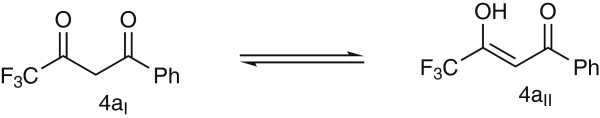
The carbonyl group adjacent to the perfluoroalkyl chain enolizes preferentially.